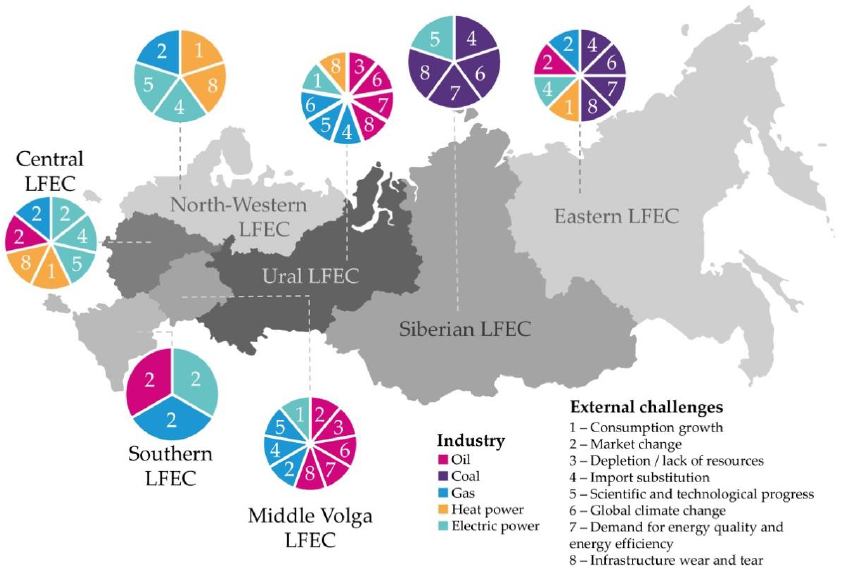
Figure 1. Map of the impact of external challenges on the fuel and energy complex of Russia.